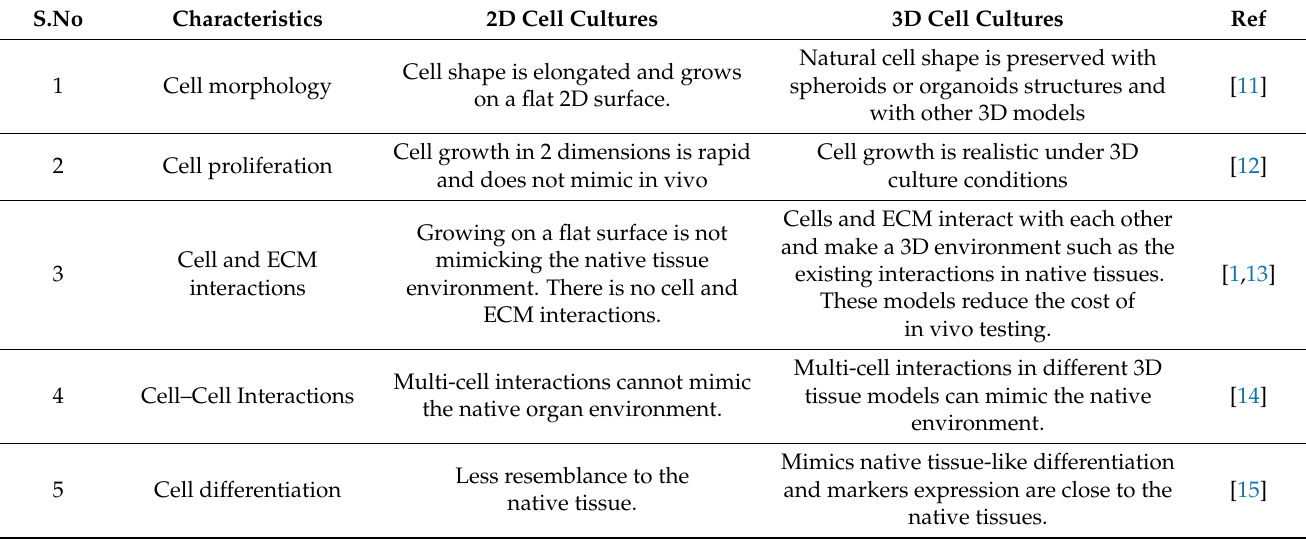
Figure 1. Schematic representation of considerations in the fabrication of 3D tissue models. Table 1. Key differences between 2D and 3D cell cultures for modeling in vivo